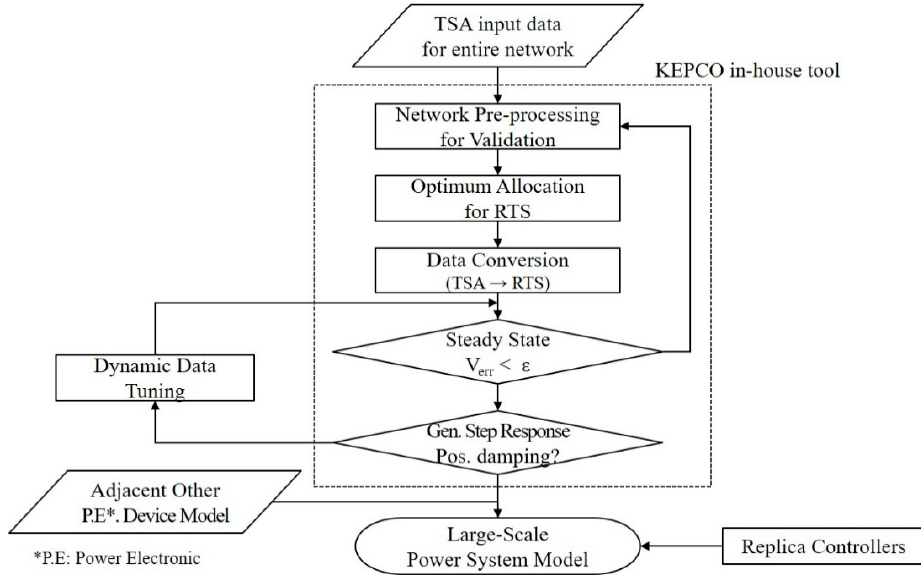
Figure 2. Flow chart of wide area network modeling procedure for real-time simulator (RTS) interfaced with replica controller.